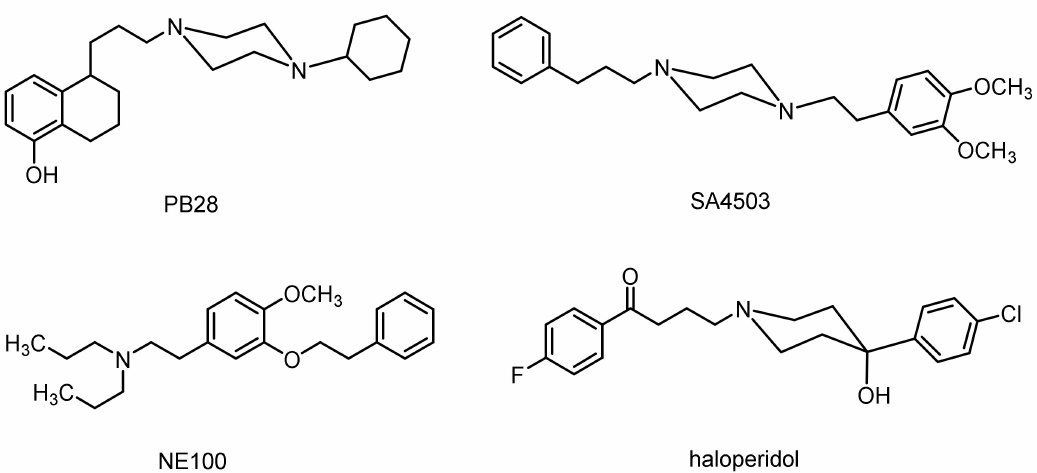
Figure 1. Some prototypical σ ligands containing flexible structural